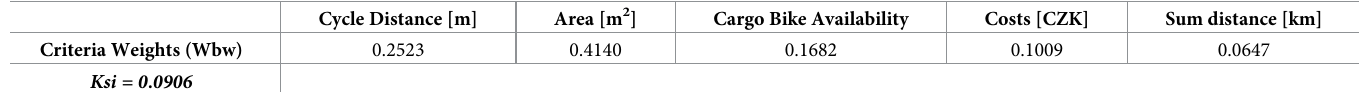
Table 11. Final criteria weights calculated by the best-worst